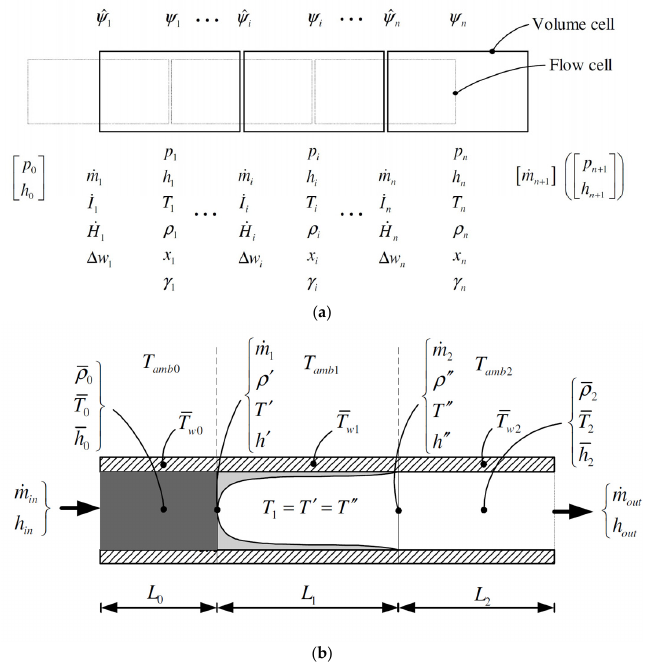
Figure 1. ( a ) Finite volume (FV) discretization and ( b ) moving boundary (MB) model [60].